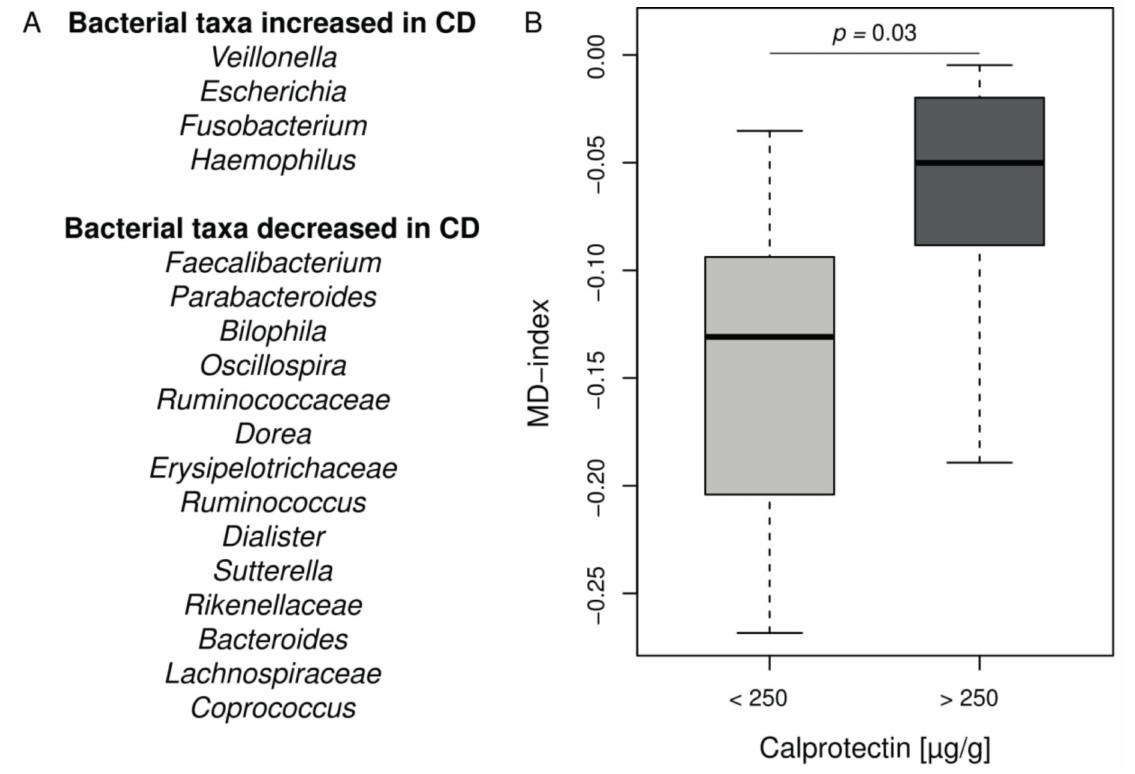
Figure 3. MD-index distribution in CF cohort according to the intestinal inflammation status. ( A ) Bacterial taxa contributing to the MD-index according to [32]. ( B ) Boxplot of MD-index values for patients separated into groups according to calprotectin level. Patients with CF intestinal inflammation have a significant higher MD-index (Wilcoxon–Mann–Whitney test, p = 0.03). For full results see Supplementary Table